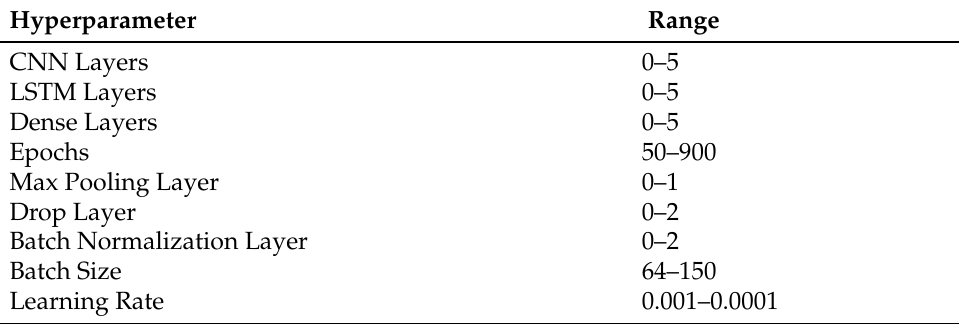
Table 5. Range of hyperparameters used in optimization